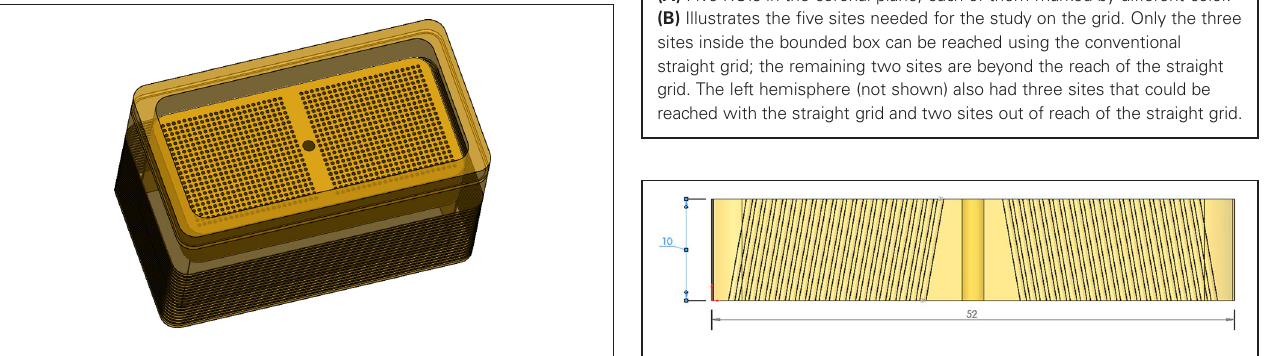
FIGURE 3 | Grid insert with two distinct angles. This scheme leaves a large trapezoidal section in the middle of the brain ROI unreachable. Dimensions in